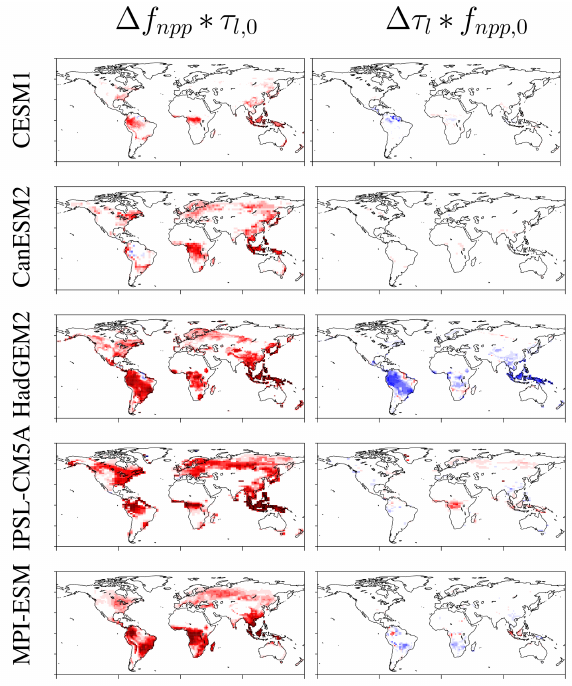
Figure 3. Responses of linearized equilibrium live carbon pools (kgCm − 2 over the interval of CO 2 doubling) in fully coupled (1pctCO2) run. Left column shows productivity-driven changes to b C l . Right column shows turnover-driven changes to b C l